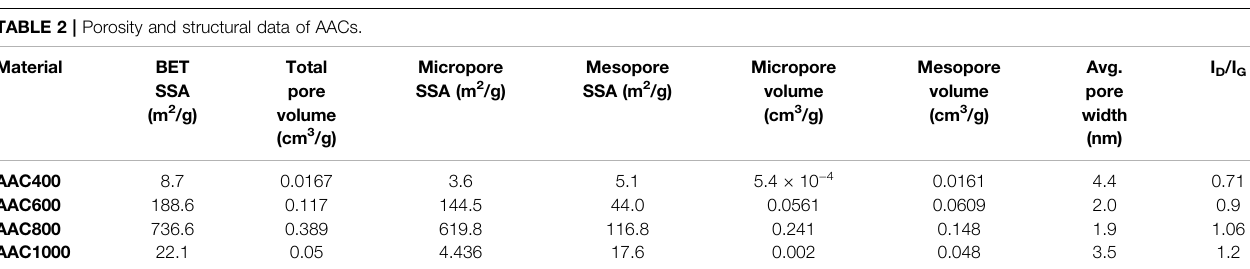
Figure S7D ). A comparative graph of AACs at 0.5 A/g is provided in Figure 6D . AAC800 exhibits a longer discharge duration for the same current density, indicating more charge storage. This is obviously attributed to organized bimodal porous structures contributing in storing a large number of ions/charges. Speci fi c capacitances were calculated from the slope of discharge curves using Equation 2 . As expected, AAC800 exhibited a maximum capacitance of 176.7 F/g at 0.5 A/g, which is 3 times higher than that of AAC600 and